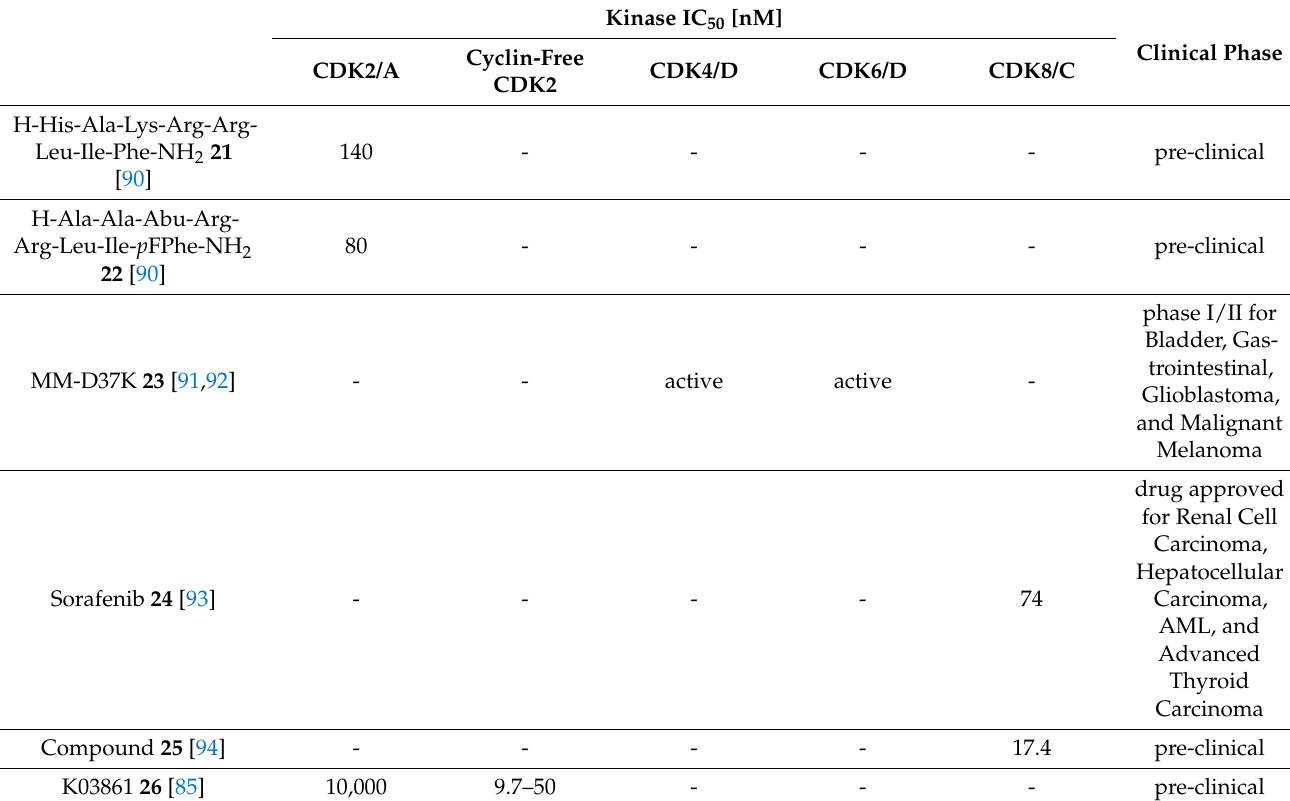
Table 4. Type II CDK inhibitors under clinical